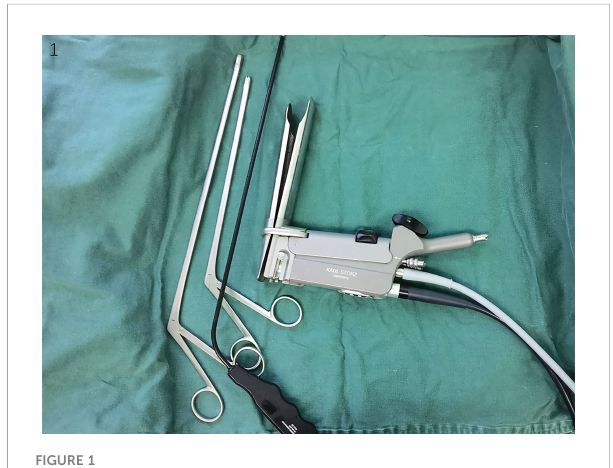
FIGURE 1 The instruments of expandable